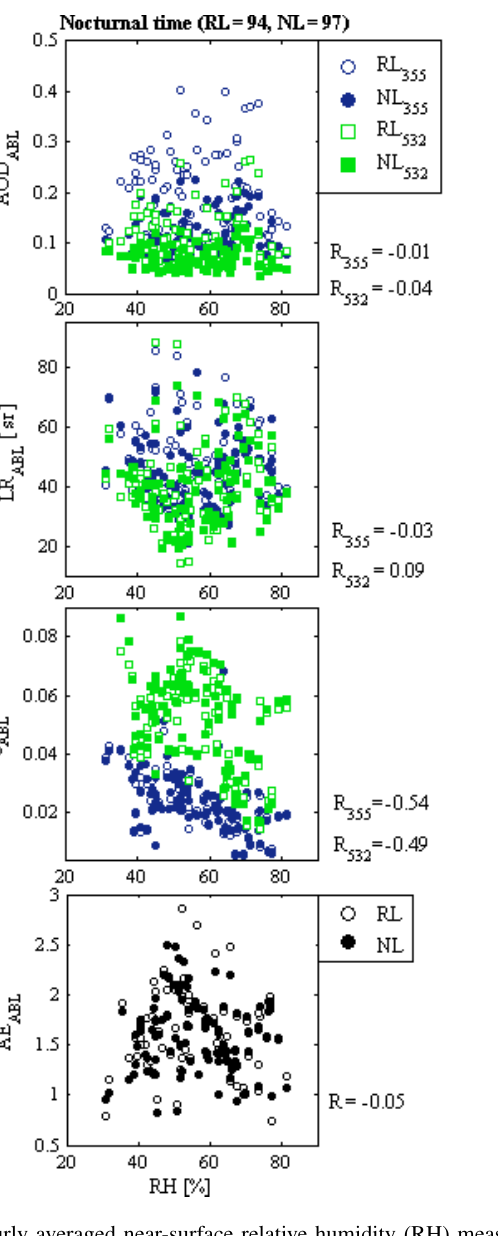
Figure 11. Hourly averaged near-surface relative humidity (RH) measured by the WXT510 (Vaisala) weather transmitter at the RS-Lab, Warsaw, vs. the aerosol optical depth (AOD), the lidar ratio (LR), the linear particle depolarization ratio ( δ ), and the Ångström exponent (ÅE) derived within the boundary layer at 355 and 532nm from the PollyXT lidar at the RS-Lab, at the EARLINET/ACTRIS site in Warsaw, for the July–September period of 2013, 2015, and